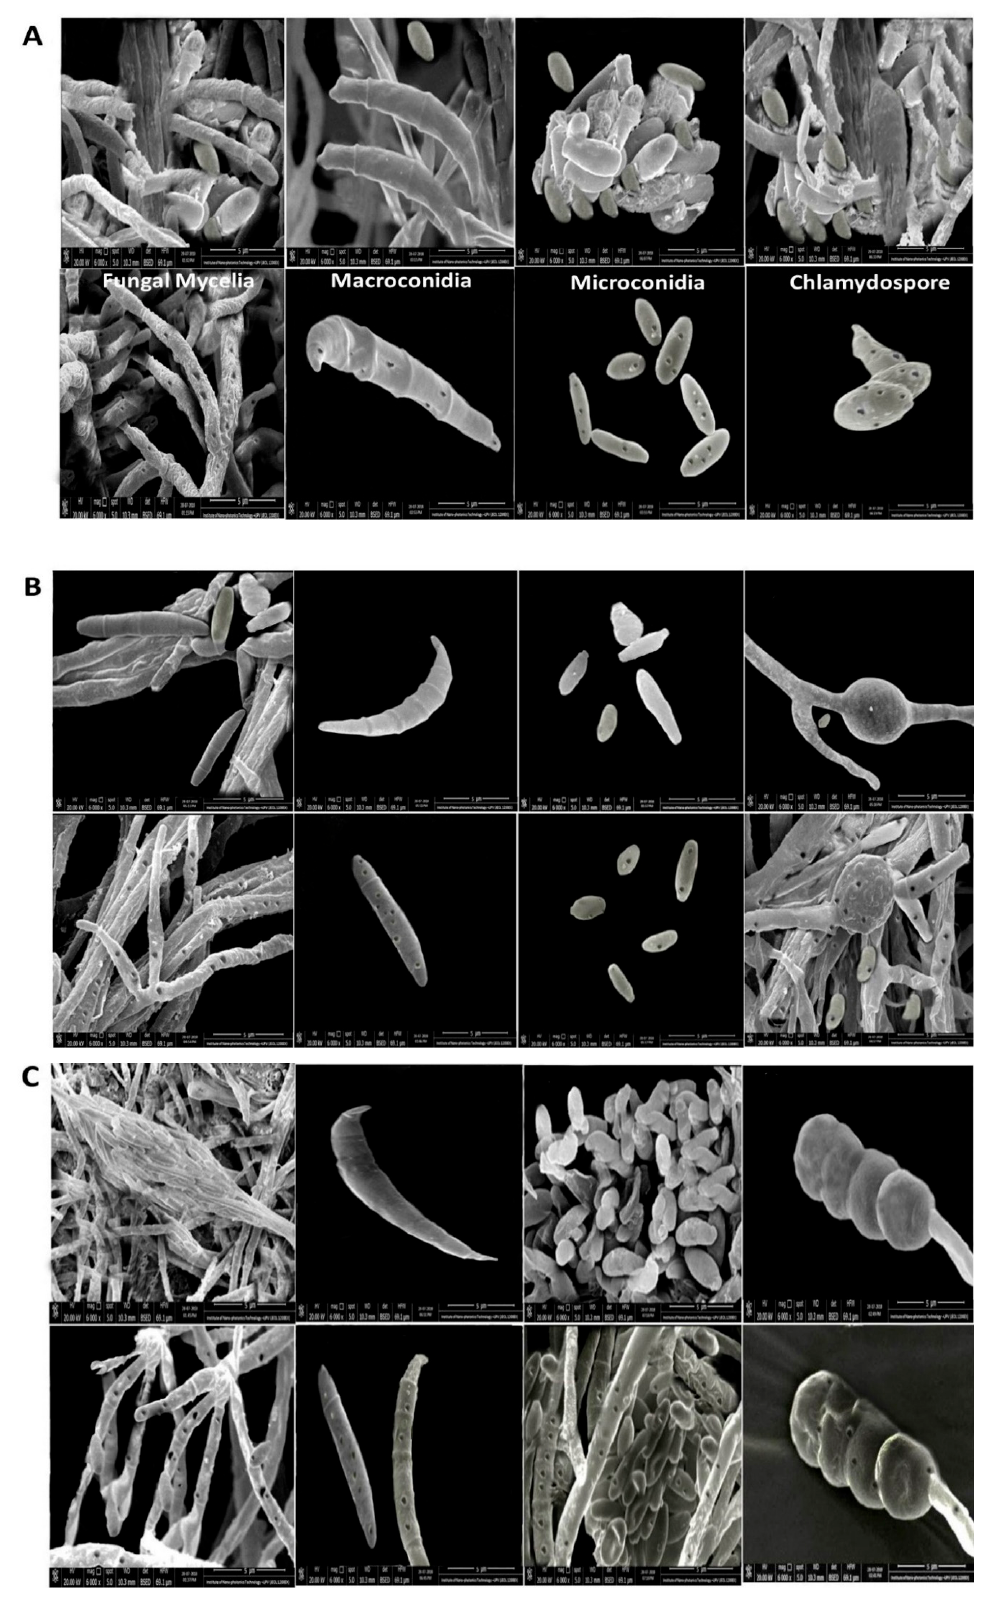
Figure 5. Effect of rGO-CuO NPs at 1 mg/L concentration on ( A ) FORL, ( B ) FOC1 and ( C ) FOC2. SEM images of mock-treated (upper rows) and NP-treated (lower row) fungi. Pictures in the different columns correspond to fungal mycelia, macroconidia, microconidia, and chlamydospores, as indicated. Next, we further investigated the antifungal activity of rGO-CuO NPs by TEM analysis. While spores treated with H 2 O, as a control, exhibited regular subcellular organelles and structures, including a smooth cell wall surface and an undamaged cyto-architecture (Figures 6A,C), in spores incubated for 1 h in 1 mg/L of rGO-CuO NPs, the nanocomposite was adsorbed onto the fungal cell wall surface (Figure 6B), and passed through the fungal cell wall layers, being distributed in the cell cytoplasm and also interacting with all cytoplasmic components (Figures 6D,E), which may be related to a change of cell permeability [43]. Figure 6. Ultra structural images obtained by TEM of ( A , C ) untreated and ( B , D , E ) rGO CuO NP- treated FORL cells. ( E ) Magnified view for treated fungal cell wall layers showing the internalization of NPs and their distribution. Red arrows point successful penetration of the rGO-CuO NPs in the fungal cells.